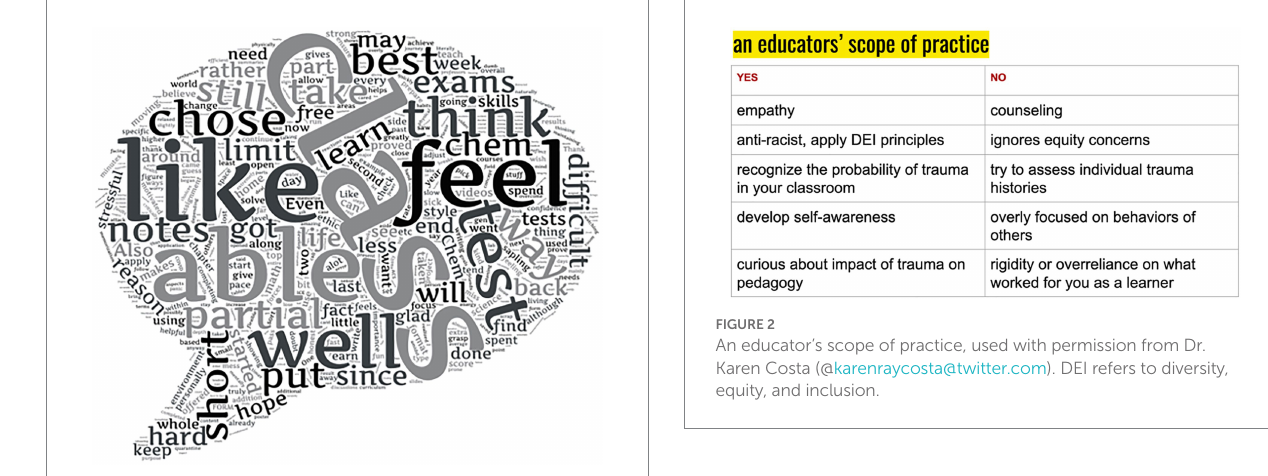
FIGURE 1 Word cloud generated from answers to a reflection question in a Spring 2020